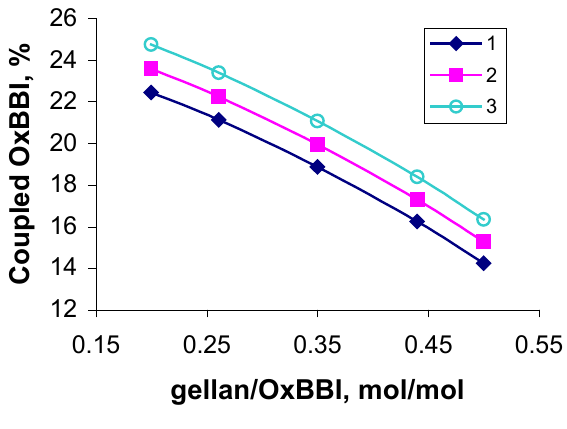
Figure 1. Influence of the gellan/OxBBI molar ratio on the coupled drug ratio, at t=21 hours, 1 – DCCI/OxBBI=1.1 mol/mol; 2 – DCCI/OxBBI=1.25 mol/mol; 3 – DCCI/OxBBI=1.4 mol/mol.